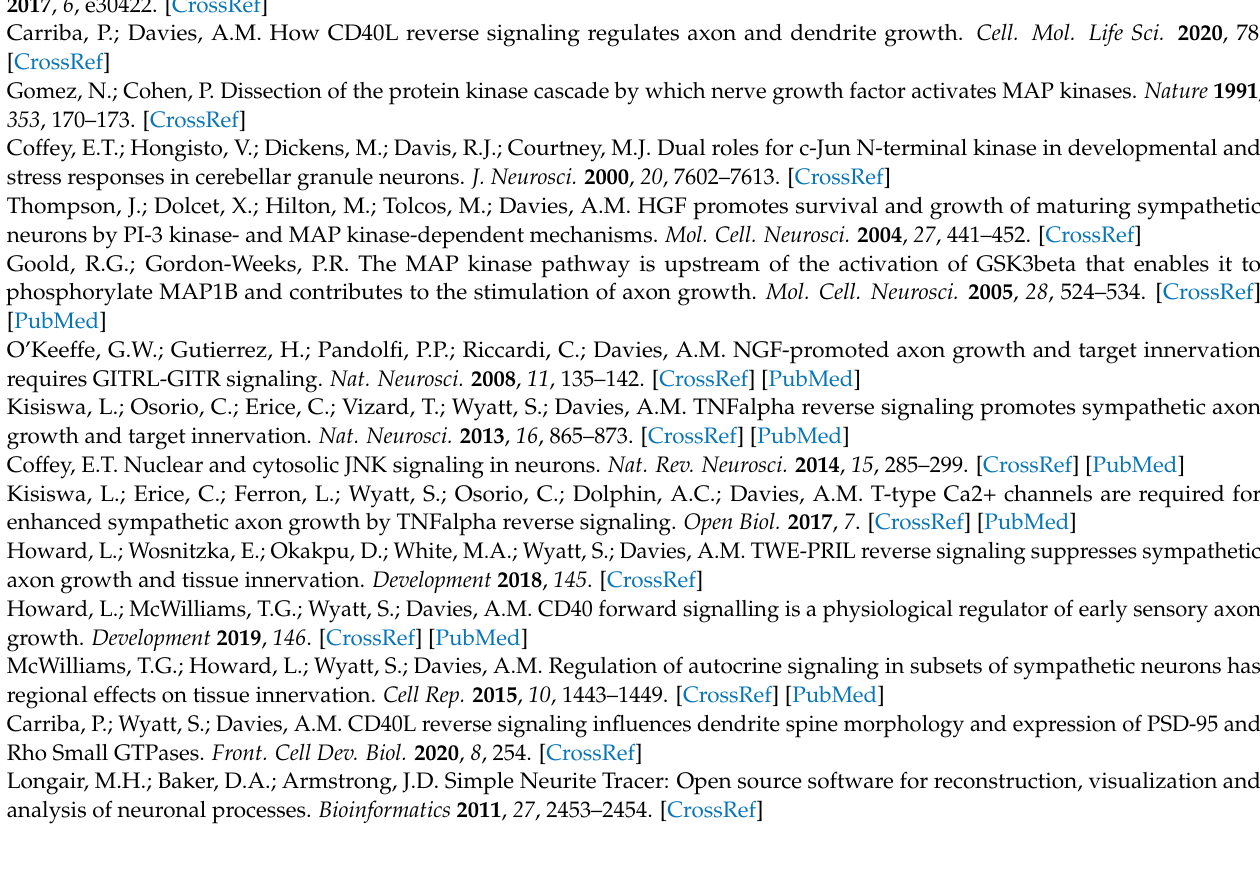
Figure S3: Basal effects on JNK, PKC and ERK1/ERK2 phosphorylation by pharmacological reagents, Table S1: Protein-protein interactions (PPI) for mouse CD40L and PKC γ and in common between CD40L and PKC γ